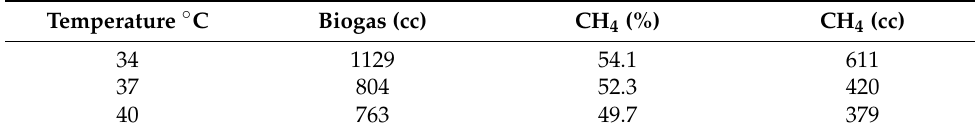
Table 7. Biogas, CH 4 % and methane obtained from sludge.